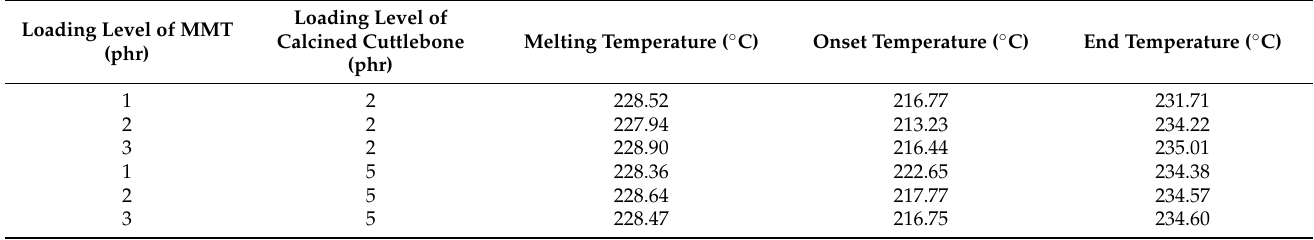
Table 1. Melting temperature, onset, and end temperature of PVOH-calcined cuttlebone-MMT composites. Loading Level of MMT